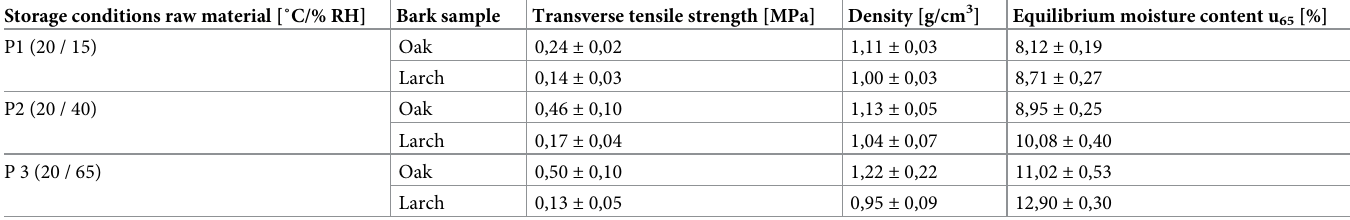
Table 1. Density, equlibirum moisture content, and transverse tensile strength of panels made of bark pressed with different moisture contents and afterwards stored at 65% RH and 20 ˚C until constant weigth. Storage conditions raw material [˚C/%